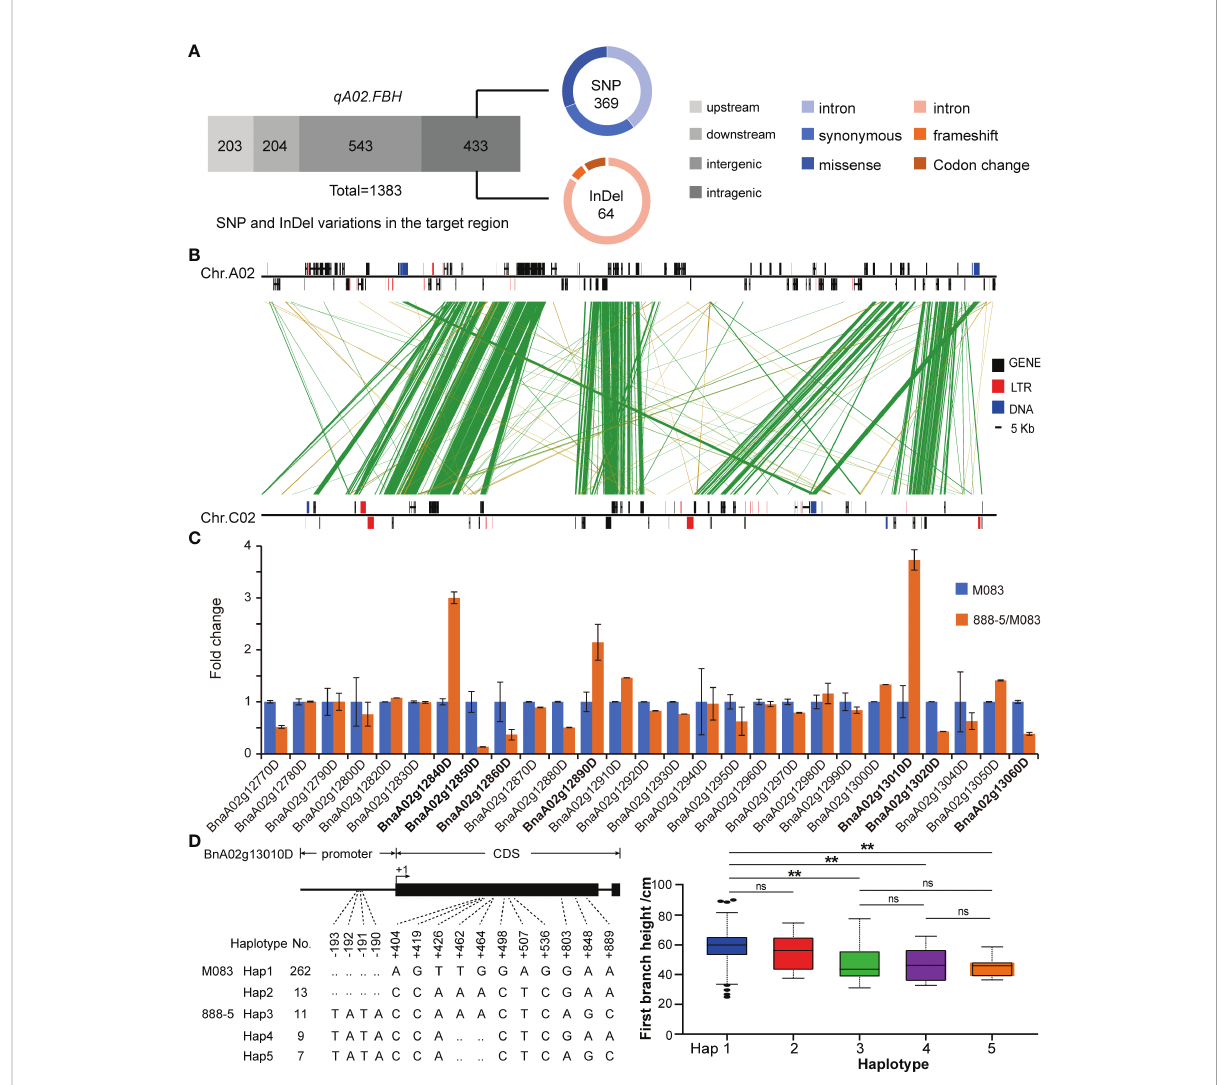
FIGURE 5 Candidate gene prediction via manifold analysis. (A) The identi fi ed variations in qA02.FBH . (B) Synteny analysis for qA02.FBH between subgenomes. (C) Expression levels of annotated genes in qA02.FBH . (D) Haplotype analysis of BnaA02g13010D based on association population in BLUP. Data are presented as means ± SD. The double asterisks represent a signi fi cant difference determined via Student ’ s t -test at P < 0.01. ns represents no signi fi